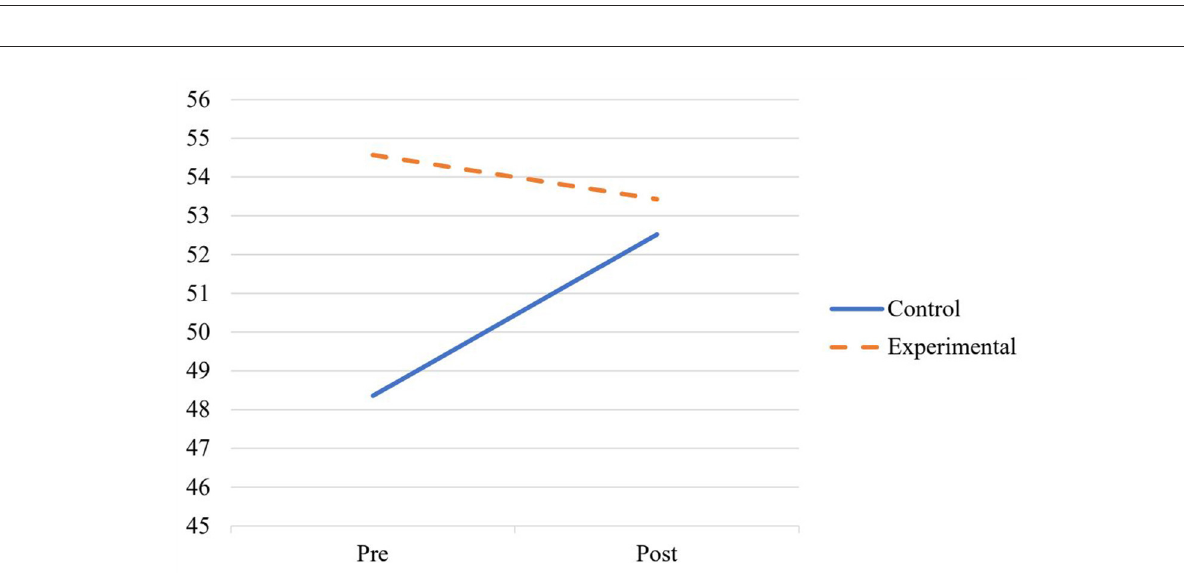
FIGURE2 Time by condition interaction on teachers’ beliefs about pedagogical programming for students identified as 2e.